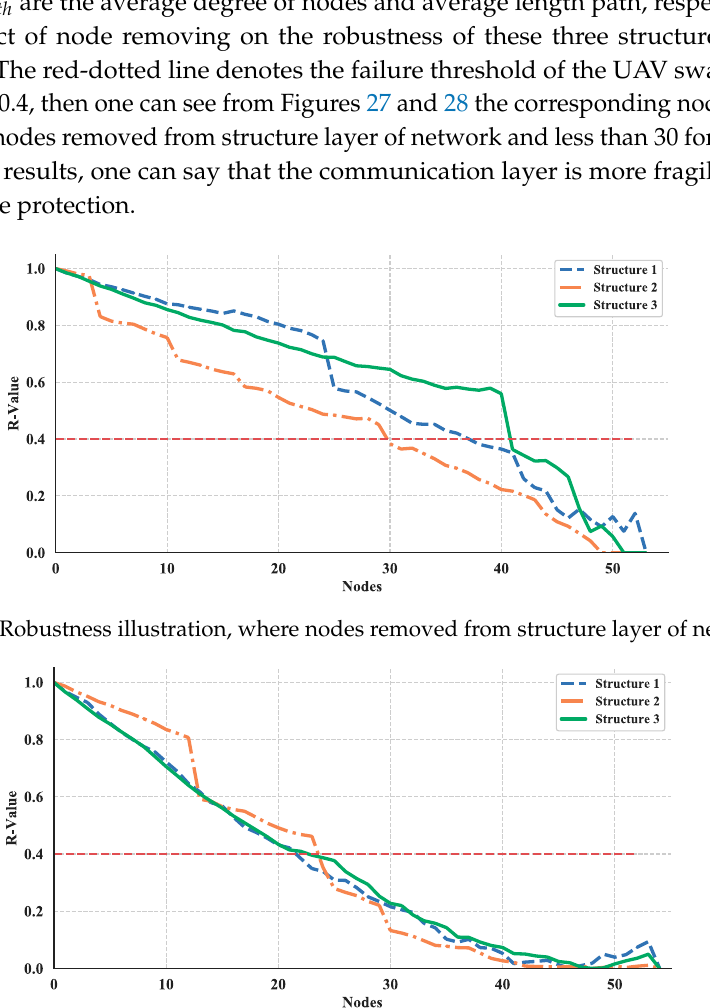
Figure 28. Robustness illustration, where nodes removed from communication layer of network.